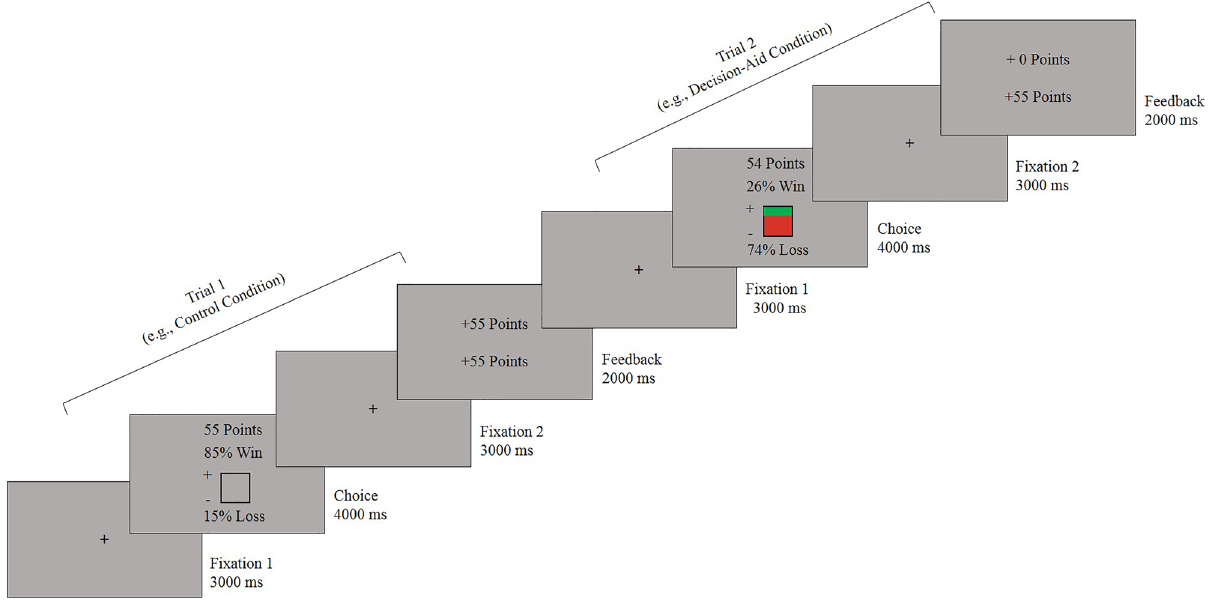
Figure 4. Schematic diagram of the mixed lottery choice task (shown here are examples of a win trial in the 1st trial and the participant accepted the gamble, followed by a loss trial in the 2nd trial, which the participant rejected). On the feedback screen, the top value indicates current gain or loss, whereas the bottom value indicates the accumulated points across reward points at stake were presented in texts on the screen. To increase probability information saliency, in the decision-aid condition, in addition to being presented in texts, a colored square was shown and within the square, the size of the area denoted by green and red colors represented the win and loss probabilities, respec- tively. In contrast, in the control condition, the same-sized square was completely filled with the background gray color. Participants had to decide to accept or reject the lottery at stake on each trial of the choice phase. After the choice was made or until a response deadline of 4 s was met, the outcome screen displayed in the feedback phase showed the points gained or lost for the current trial on the upper part of the screen as well as the total accumulated points across trials thus far on the lower part of the screen (see Fig. 4 for trial structure and condi- tion type).